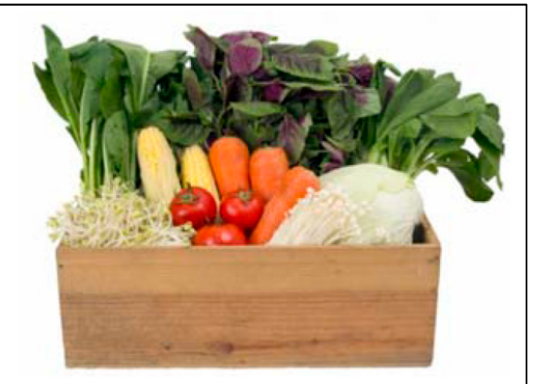
Figure 1. The example of fresh food box used in the questionnaire (Source: The website of Leezen. Leezen.com.tw; accessed on 1 July 2019).